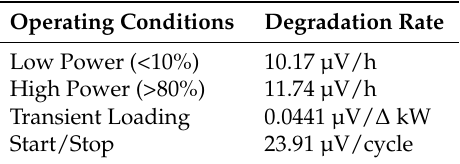
Table 1. Fuel cell performance loss